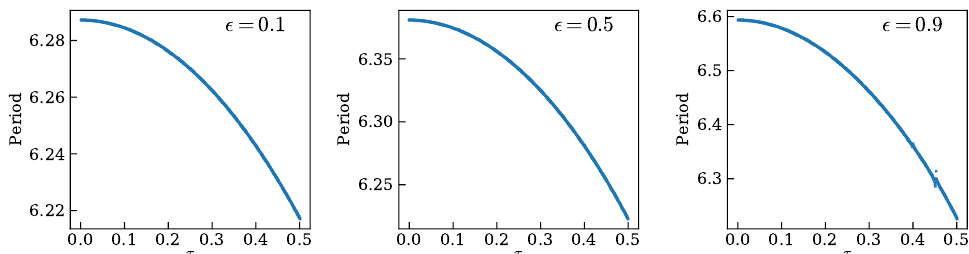
Figure 4. Dependence of the period of the numerical solution of the van der Pol limit cycle with respect to the time step for (cid:101) ∈ { 0.1,0.5,0.9 } increasing from left to right.